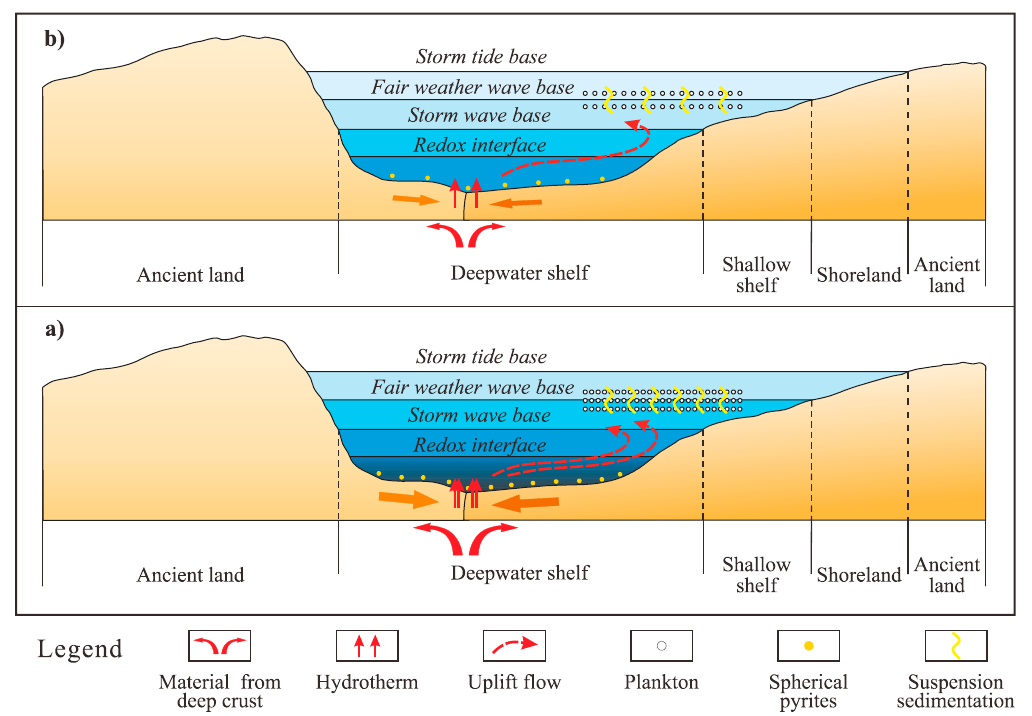
Figure 6. The model of organic matter enrichment in Well X, the Lower Yangtze. ( a ) In TST1 of the Late Ordovician; ( b ) In RST1, TST2, and RST2 of the Late Ordovician and the Early Silurian. See Figure 1 for the well location.